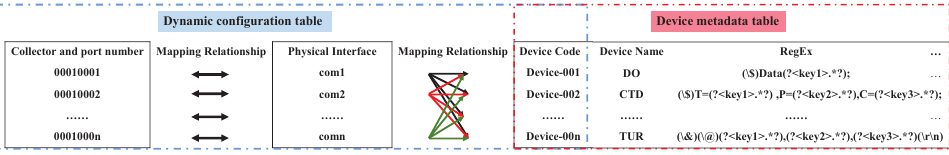
Figure 6. The mapping diagram of dynamic device management.